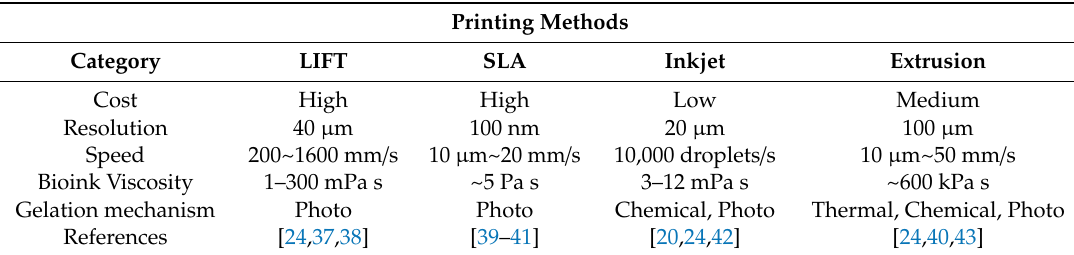
Table 1. Comparison of 3D cell printing